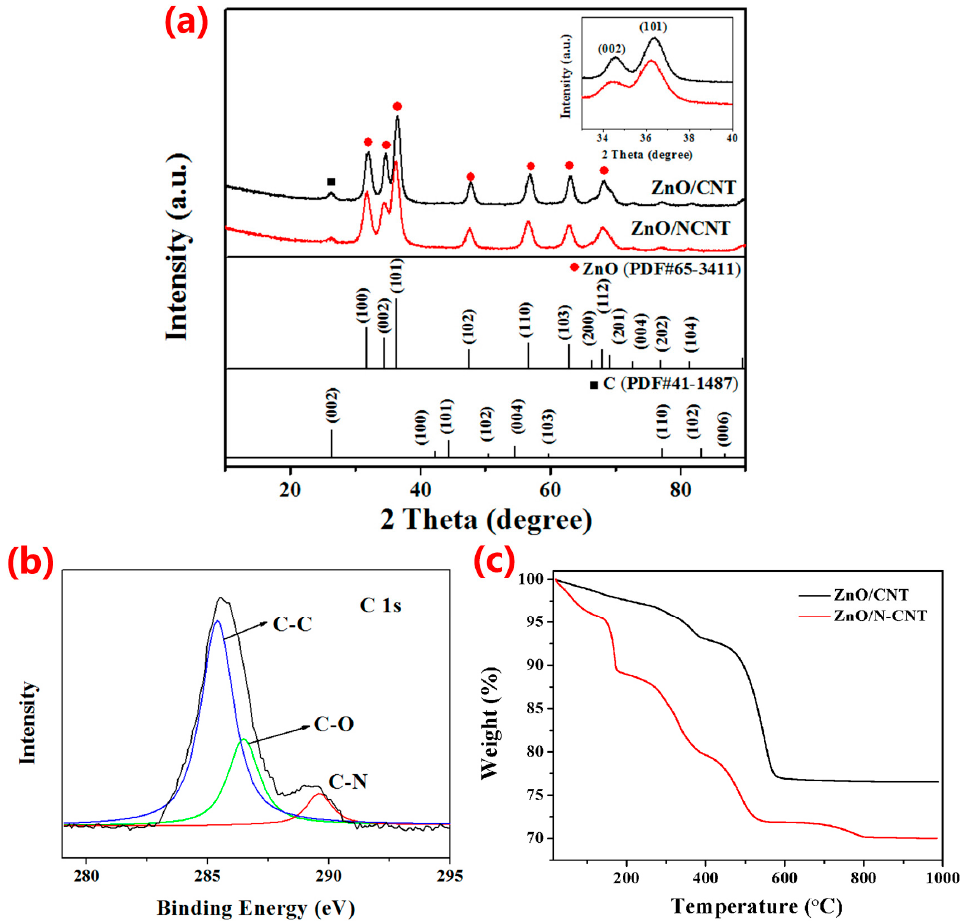
Figure 1. ( a ) XRD patterns of ZnO/NCNT and ZnO/CNT composites; inset: enlarged picture of XRD peaks appearing at 33–40°; ( b ) High-resolution XPS spectrum of C 1s of the ZnO/NCNT composite; ( c ) TG curves of the ZnO/NCNT and ZnO/CNT composites at a heating rate of 10 °C min − 1 under air.